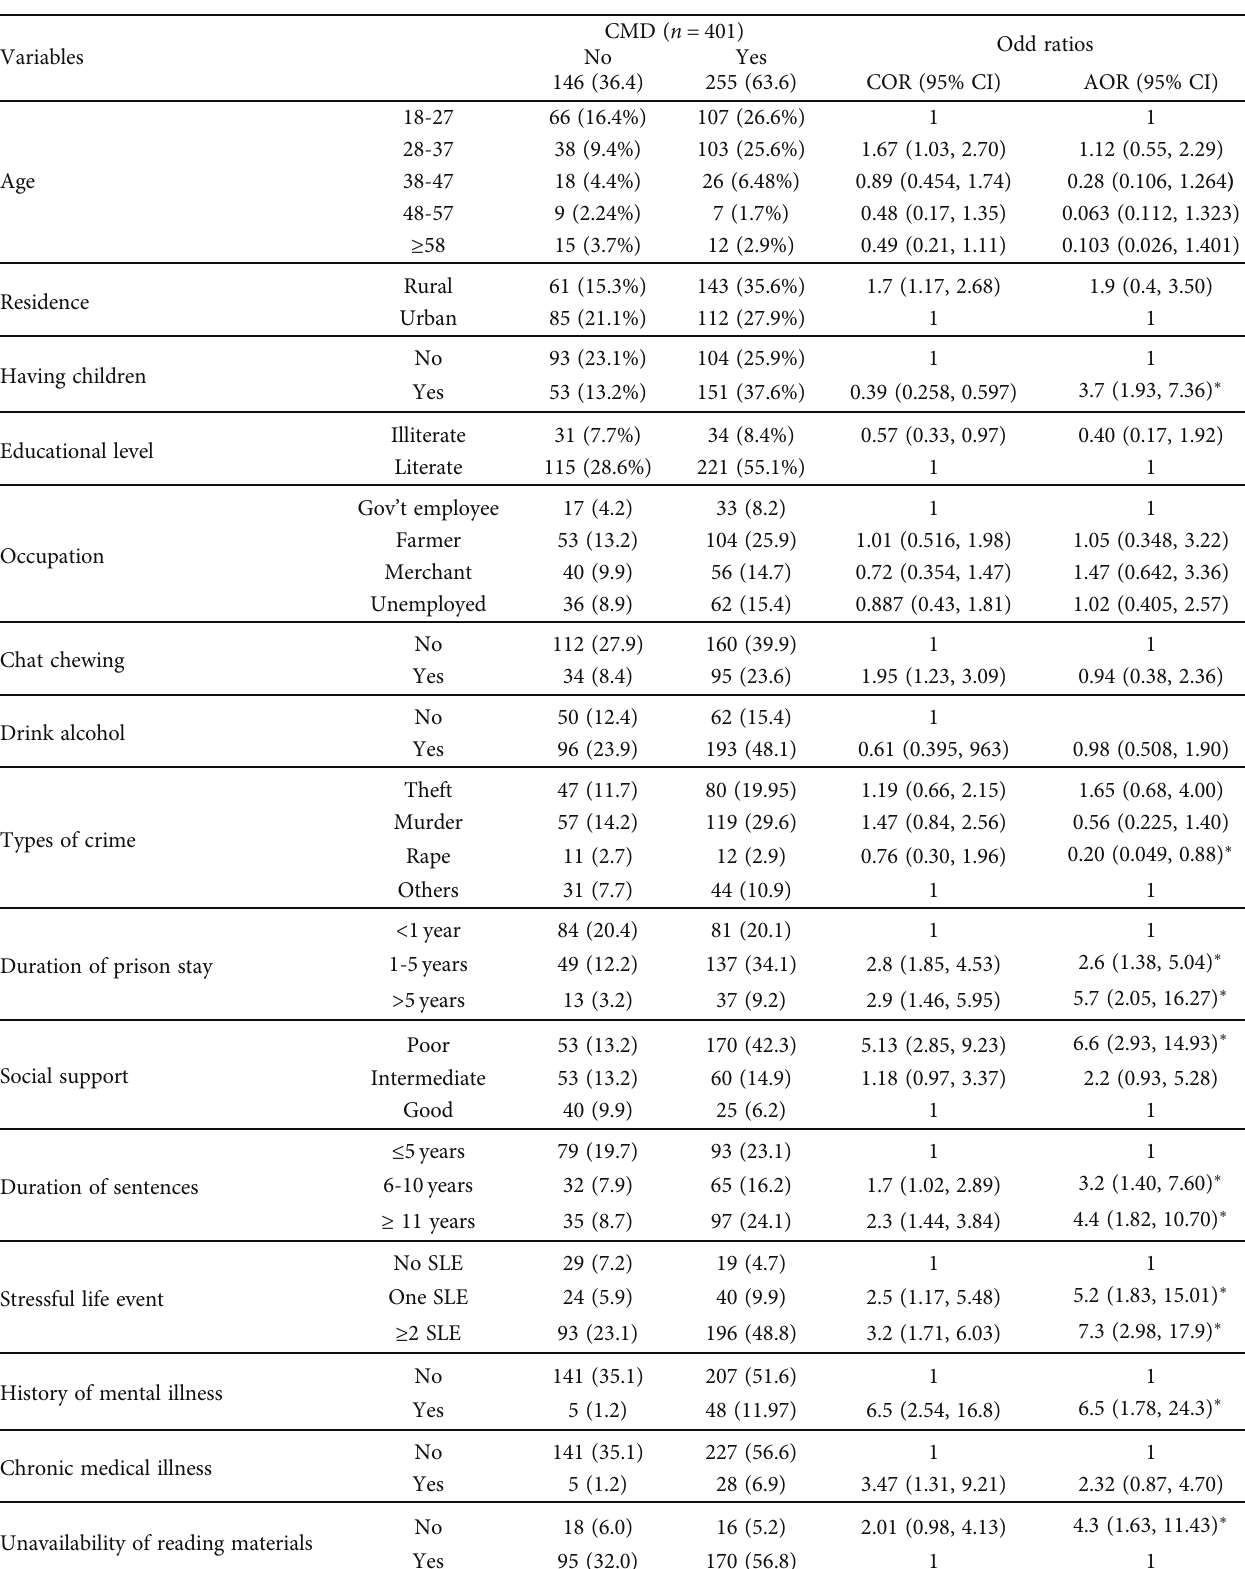
Table 4: Bivariable and multivariable regression results on common mental disorder and its associated factors among prisoners in North Wollo zone prison institutions, Northeastern